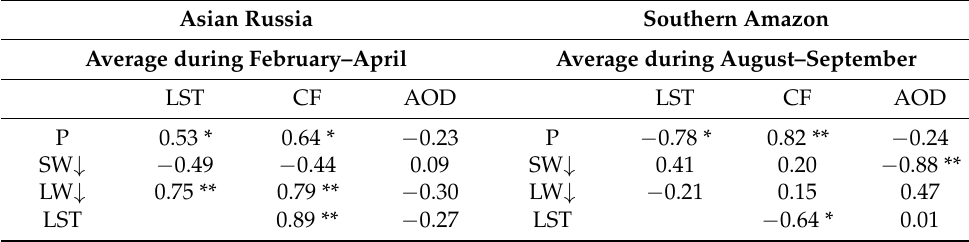
Table 2. Correlation coefficients (R) between the time series of various climatic variables shown in Figure 4 over Asian Russia and the southern Amazon for the period of